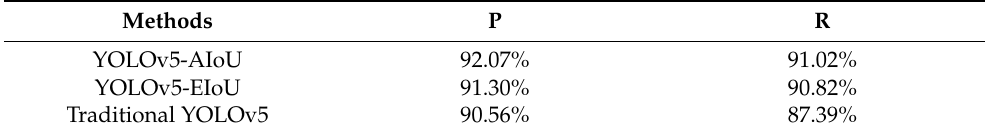
Table 2. Different loss function detection results.